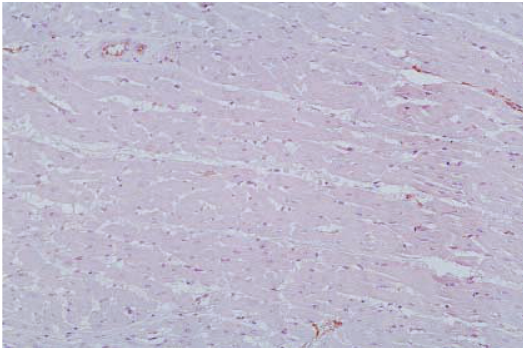
Figure 2 Factor VIII immunostaining of a sample of the growth factor group (image width = 0.8 mm). Both arteriolar or capillary densities are clearly increased when compared with figure